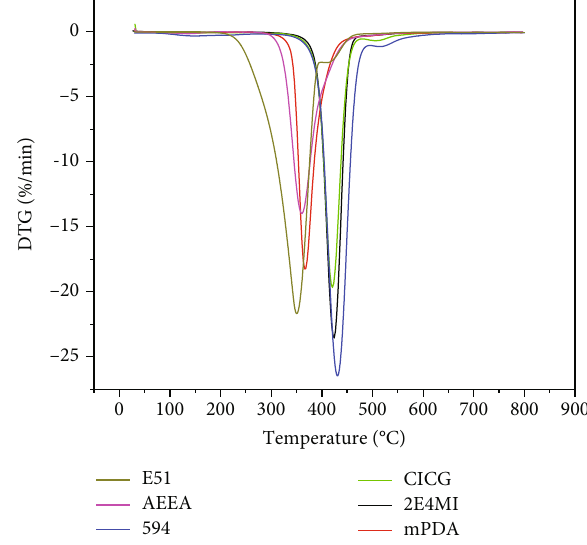
Figure 3: Derivative thermogravimetry (DTG) curves of the EP matrixes. The peak thermal decomposition temperatures of E51 EP, AEEA EP, 594 EP, CICG EP, 2E4MI EP, and mPDA EP were 342.9 ° C, 360.4 ° C, 430.16 ° C, 420.7 ° C, 424.0 ° C, and 367.1 ° C,